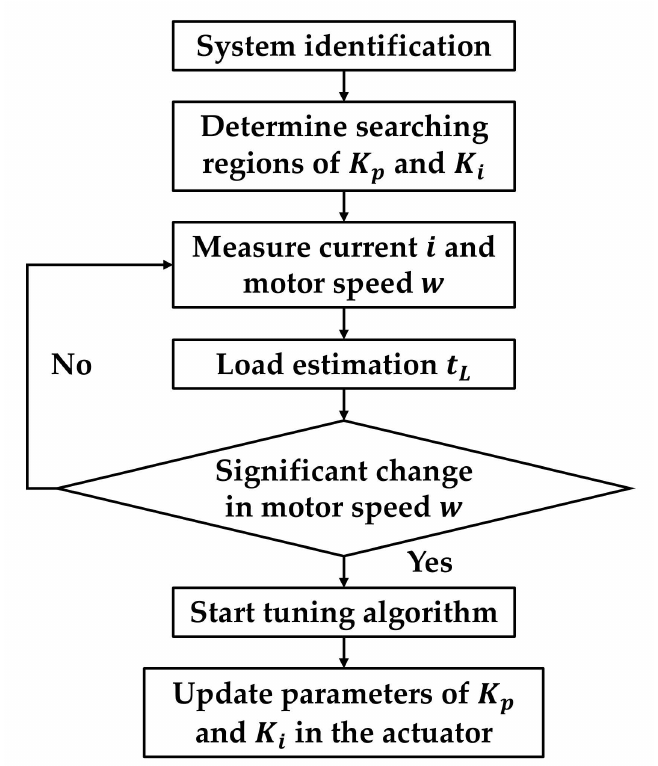
Figure 8. Flowchart of the proposed online-tuning